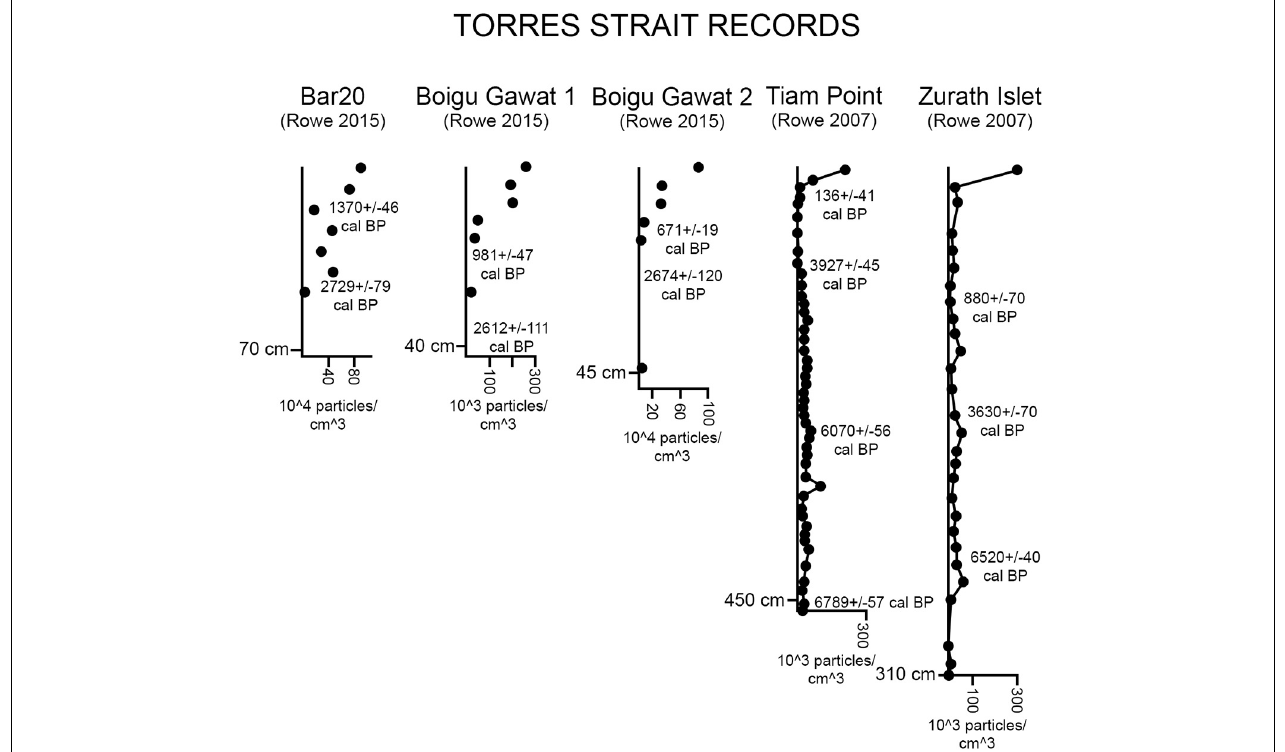
FIGURE 9 | A selection of previously published charcoal records from Torres Strait (adapted from Rowe, 2007, 2015); refer to Figure 1 for location of Torres Strait north of Cape York Peninsula. Note that scales vary between records and all are plotted relative to depth. Length of Y axis is approximately scaled to maximum age for visual